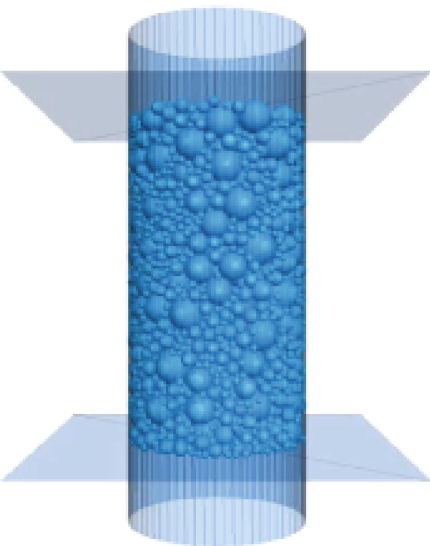
Figure 1: Triaxial test model.